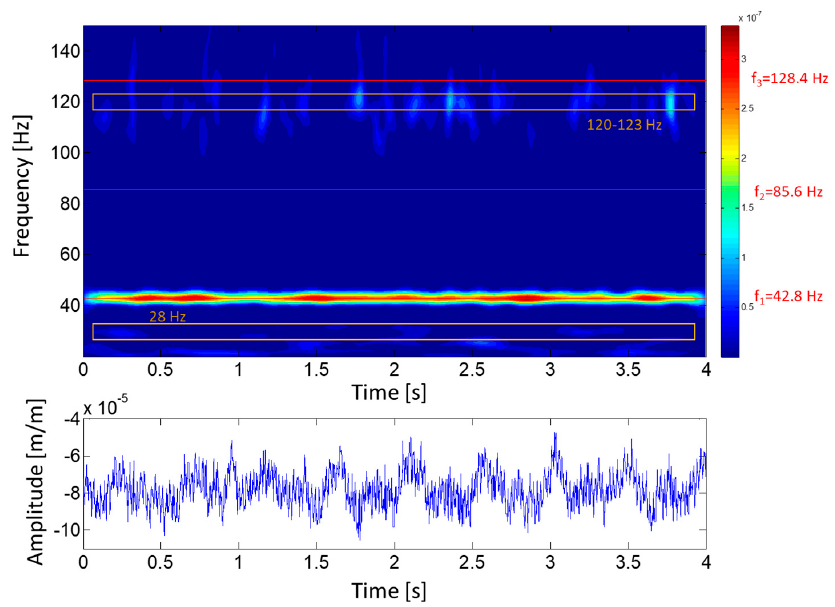
Figure 10. Joint time–frequency plot of a strain gauge signal (crown side, pressure side, blade 7) during DPL (18% of rated power).